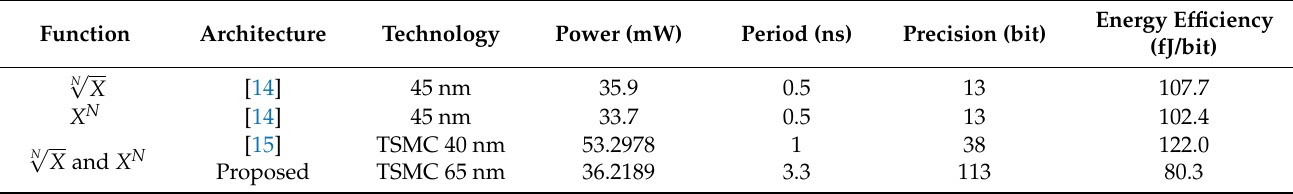
Table 7. Power analysis for [14,15] and the proposed